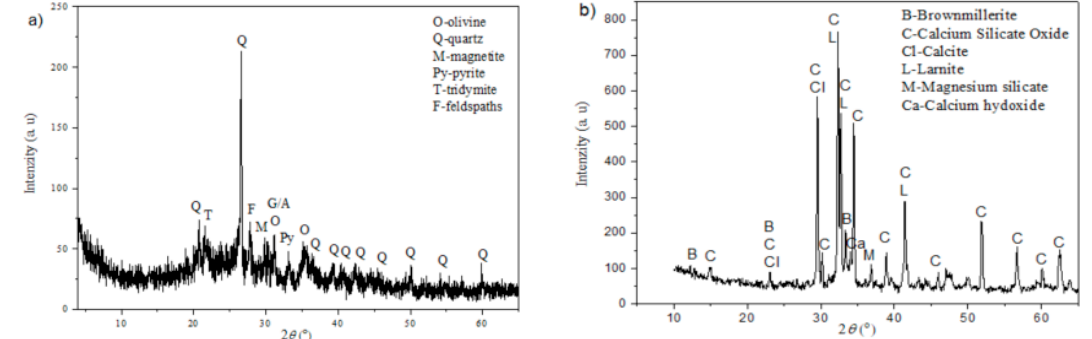
Figure 1. Results of the XRD analyses of the ( a ) slag and ( b ) CEM I 42.5R.